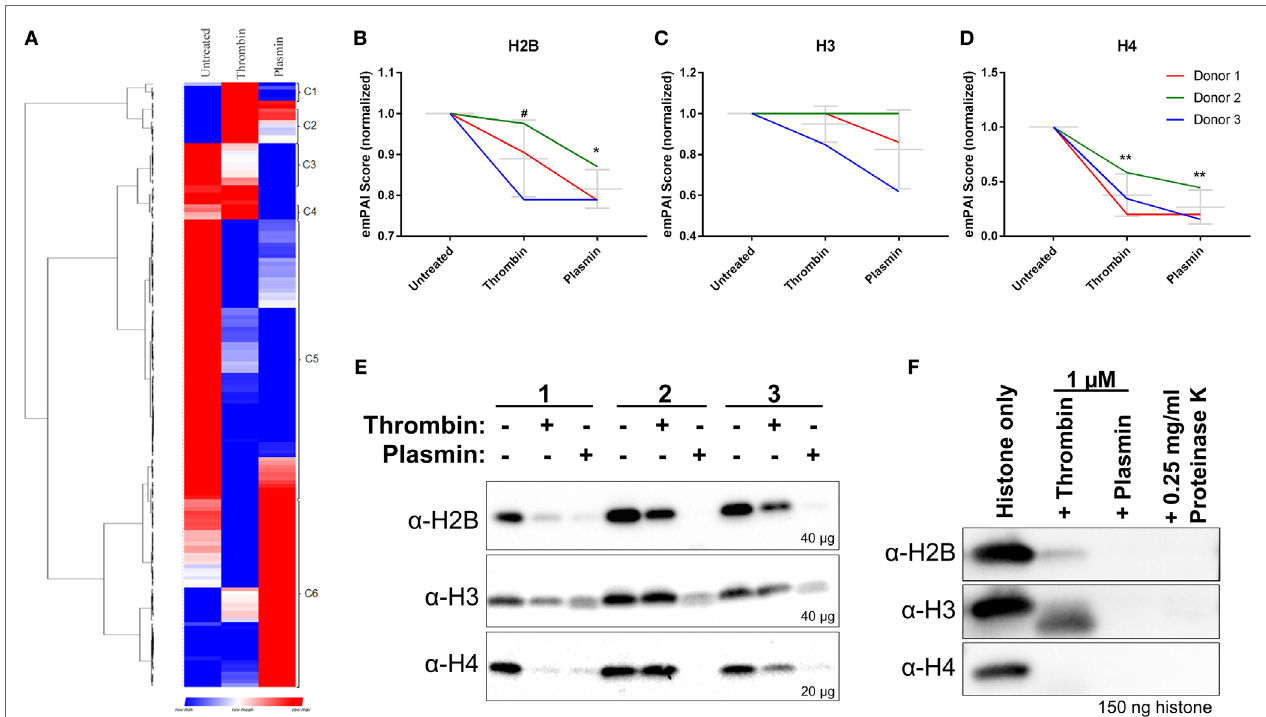
FigUre 4 | Reduced major histones on neutrophil extracellular traps (NETs) by thrombin and plasmin. (a) Hierarchical clustering of identified NET-associated proteins following data processing in Figure S1 in Supplementary Material. Enriched proteins are displayed in red , lowered proteins, are displayed in blue and the intermediate values are displayed in the shades of red and blue . (B–D) The histones’ exponentially modified protein abundance index (emPAI) scores from thrombin- and plasmin-treated samples were normalized against the respective donor’s untreated control. Donor-matched samples are presented ( n = 3). (B) emPAI scores for histone H2B subtypes E and F for each treatment were summed then normalized against the untreated control. (c) emPAI scores for histone H3 and variant H3.3 for each treatment were summed then normalized against the untreated control. (D) Normalized histone H4 emPAI scores. (e) Western blot analyses on + DNase samples using α -H2B (~12 kDa; upper panel ), α -H3 (~11 kDa; middle panel ), and α -H4 (~9 kDa; lower panel ) antibodies. Amounts of proteins loaded for each sample were as indicated. (F) Recombinant histones H2B, H3.3, and H4 (2 µM) were treated with 1 µM thrombin, 1 µM plasmin, or 0.25 mg/ml proteinase K for 2 h at 37°C before sodium dodecyl sulfate-polyacrylamide gel electrophoresis with 150 ng of the respective histones and western blotting. Antibodies used